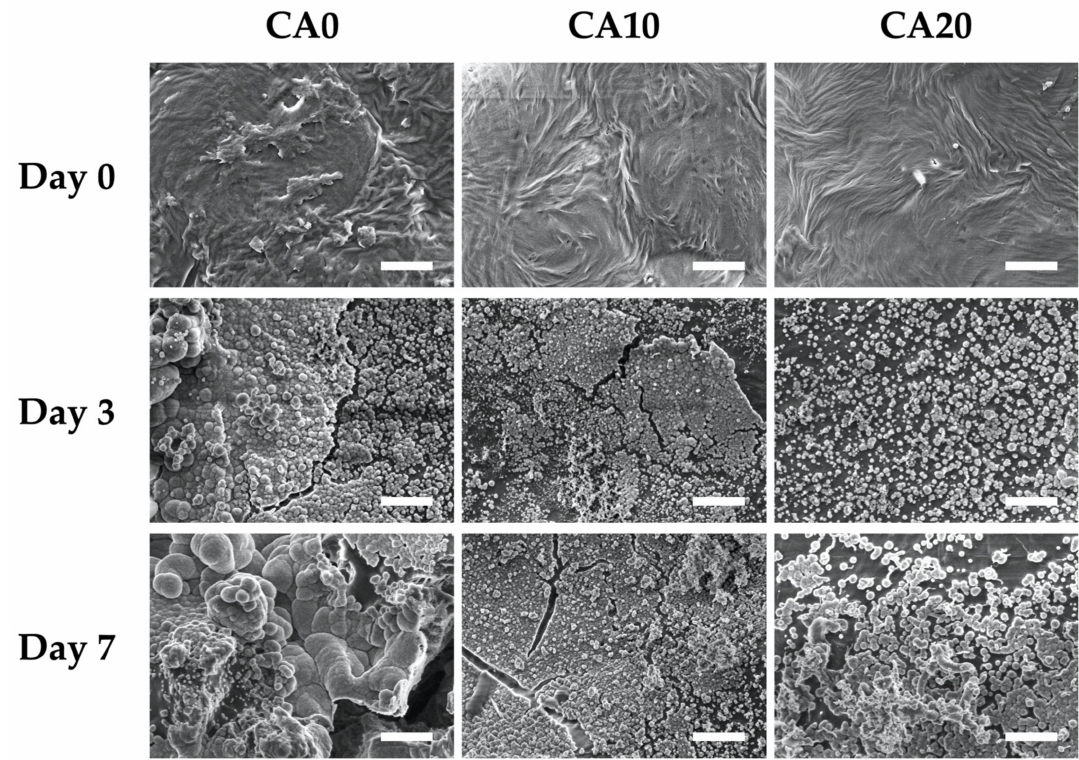
Figure 4. Surface microstructure of the CA0, CA10, and CA20 scaffolds before and after immersion in SBF for 3 and 7 days. The scale bar is 2 µ